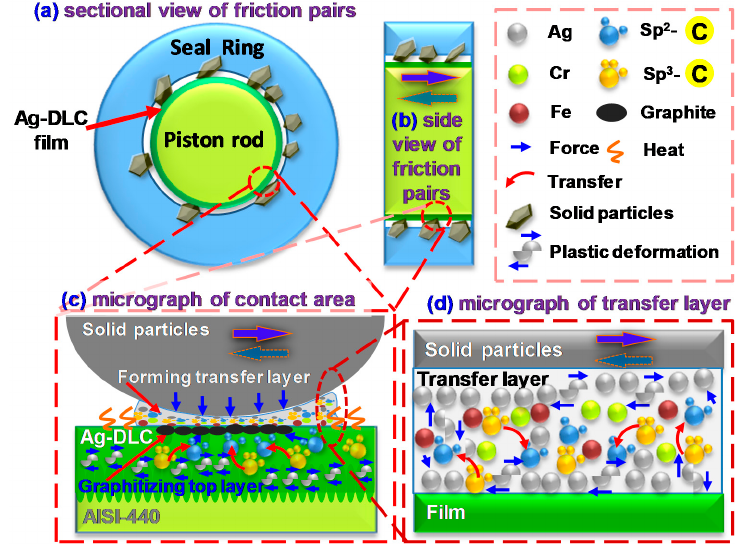
Figure 8. Schematic diagram of action mechanism of Ag-DLC film to improve the sealing performance. ( a ) sectional view of friction pairs, left top; ( b ) side view of friction pairs, right top; ( c ) micrograph of contact area, left bottom; ( d ) micrograph of transfer layer, right bottom.